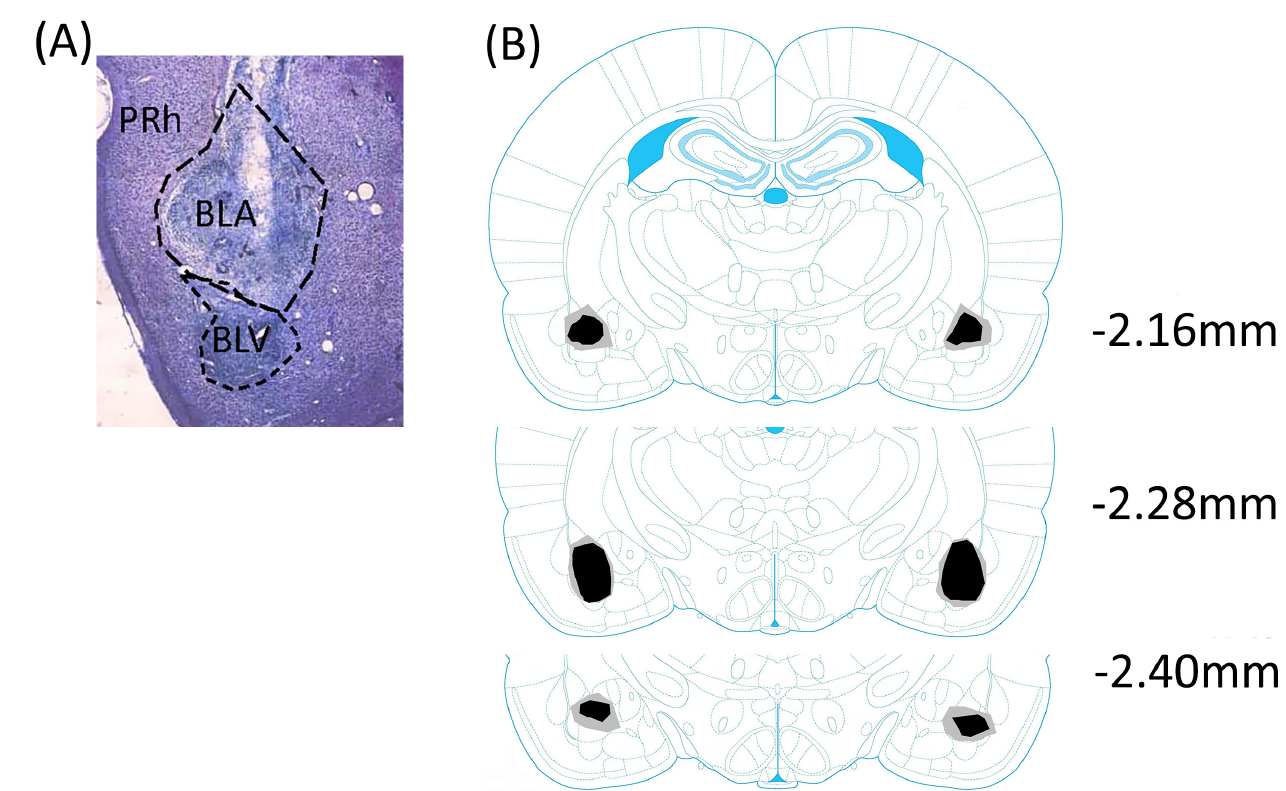
Figure 2. ( A ). Digitalized photomicrographs of thionin-stained coronal sections in the basolateral amygdala. ( B ). Microinjection placements of the largest (gray) and smallest (black) in the basolateral amygdala at three coronal levels ( − 2.16, − 2.28, and − 2.40 mm posterior to bregma).